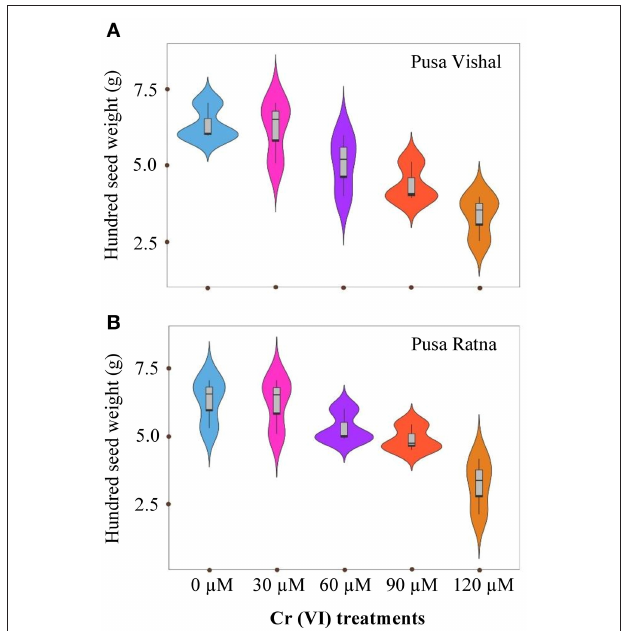
FIGURE 9 | Violin plots screening the distribution of values for hundred seed weight (HSW) in two Mungbean cultivars grown in pot conditions under chromium (Cr [VI]) stress. (A) Pusa Vishal (PV) and (B) Pusa Ratna (PR).